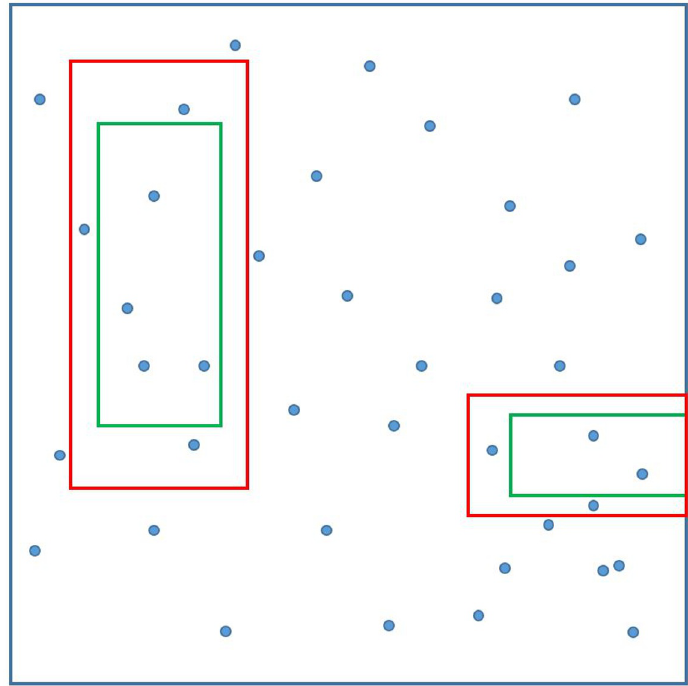
Figure 3 . Representation of the multi-dimensional sideband method for box density estimation. Two possible search boxes in a 2-dimensional space are shown in green; the relative sidebands, constructed according to the recipe of eq. (2.6), are the regions between the red and the green